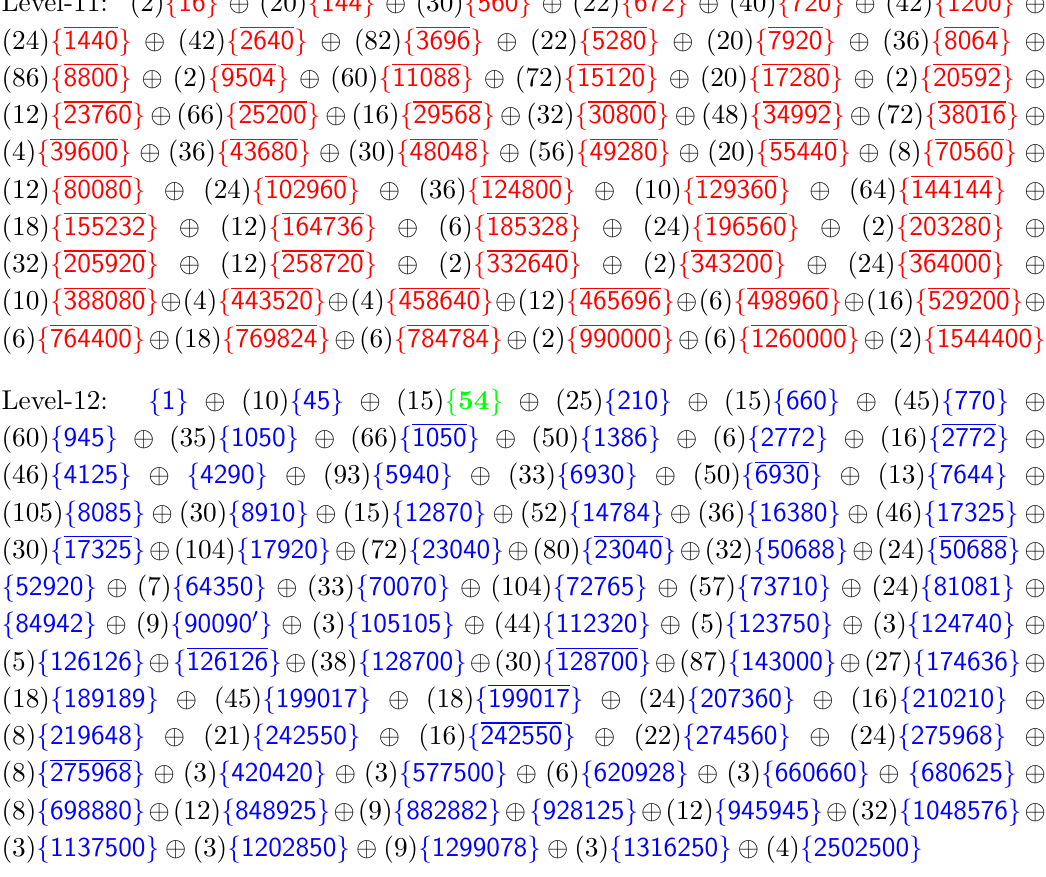
(cid:15) Level-13: (10) f 16 g (cid:8) (30) f 144 g (cid:8) (80) f 560 g (cid:8) (10) f 672 g (cid:8) (60) f 720 g (cid:8) (50) f 1200 g (cid:8) (60) f 1440 g (cid:8) (50) f 2640 g (cid:8) (110) f 3696 g (cid:8) (50) f 5280 g (cid:8) (24) f 7920 g (cid:8) (84) f 8064 g (cid:8) (138) f 8800 g(cid:8) (84) f 11088 g(cid:8) (100) f 15120 g(cid:8) (24) f 17280 g(cid:8) (12) f 20592 g(cid:8) (36) f 23760 g(cid:8) (96) f 25200 g (cid:8) (6) f 26400 g (cid:8) (20) f 29568 g (cid:8) (40) f 30800 g (cid:8) (90) f 34992 g (cid:8) (116) f 38016 g (cid:8) (12) f 39600 g (cid:8) (78) f 43680 g (cid:8) (62) f 48048 g (cid:8) (2) f 48048 0 g (cid:8) (80) f 49280 g (cid:8) (42) f 55440 g (cid:8) (106) f 144144 g (cid:8) (36) f 155232 g (cid:8) (48) f 164736 g (cid:8) (48) f 196560 g (cid:8) (22) f 196560 0 g (cid:8) (8) f 198000 g (cid:8) (84) f 205920 g (cid:8) (10) f 224224 g (cid:8) (28) f 258720 g (cid:8) (12) f 274560 0 g (cid:8) (4) f 308880 g (cid:8) (6) f 332640 g (cid:8) (18) f 343200 g (cid:8) (32) f 364000 g (cid:8) (24) f 388080 g (cid:8) (18) f 388080 0 g (cid:8) (2) f 428064 g (cid:8) (12) f 443520 g (cid:8) (6) f 458640 g (cid:8) (12) f 465696 g (cid:8) (2) f 522720 g(cid:8) (4) f 524160 g(cid:8) (54) f 529200 g(cid:8) (10) f 764400 g(cid:8) (4) f 764400 0 g(cid:8) (24) f 769824 g(cid:8) (2) f 831600 0 g (cid:8) (16) f 905520 g (cid:8) (12) f 1260000 g (cid:8) (18) f 1441440 g (cid:8) (6) f 1544400 g (cid:8) (6) f 1924560 g (cid:8) (6) f 2274480 g (cid:8) (2) f 2310000 g (cid:8) (6) f 2402400 g (cid:8) (2) f 2642640 g (cid:15) Level-14: (10) f 10 g (cid:8) (55) f 120 g (cid:8) (15) f 126 g (cid:8) (35) f 126 g (cid:8) (15) f 210 0 g (cid:8) (60) f 320 g (cid:8) (120) f 1728 g (cid:8) (6) f 1782 g (cid:8) (105) f 2970 g (cid:8) (65) f 3696 0 g (cid:8) (105) f 3696 0 g (cid:8) (105) f 4312 g (cid:8) (70) f 4410 g (cid:8) (40) f 4608 g (cid:8) (60) f 4950 g (cid:8) (68) f 4950 g (cid:8) (21) f 6930 0 g (cid:8) (40) f 6930 0 g (cid:8) f 9438 g (cid:8) (100) f 10560 g (cid:8) (9) f 20790 g (cid:8) (5) f 20790 g (cid:8) (76) f 27720 g (cid:8) (88) f 28160 g (cid:8) (8) f 31680 g (cid:8) (78) f 34398 g (cid:8) (203) f 36750 g (cid:8) (28) f 37632 g (cid:8) (36) f 42120 g (cid:8) (45) f 46800 g (cid:8)